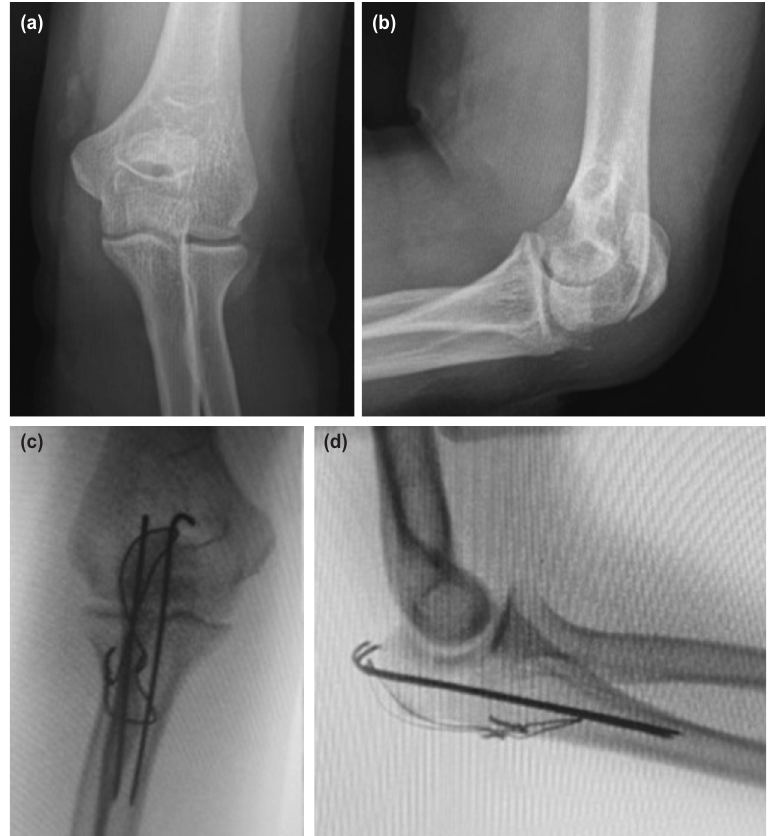
Case radiographs. (a) Pre-operative elbow AP and (b) Lateral views. (c) Final elbow AP and (d) Lateral views. Fig. 1: